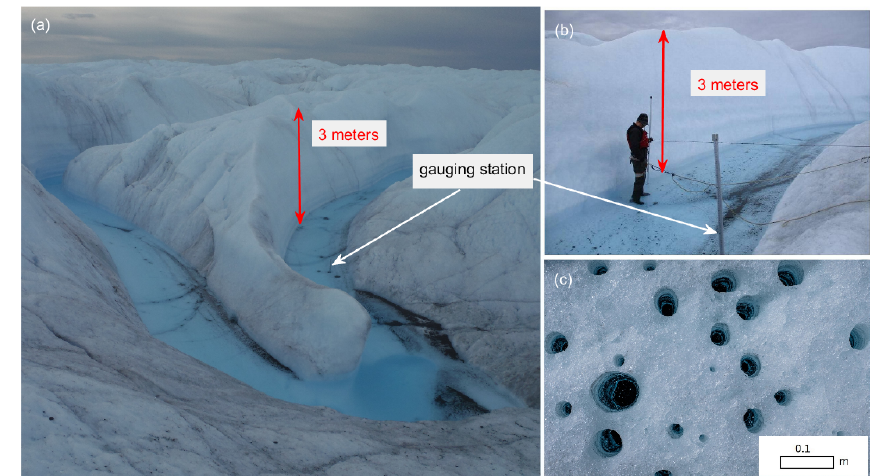
Figure 2. (a) Supraglacial stream main stem and gauging station location. (b) Close-up photo of the stream cross-section and the gauging station during discharge measurement. (c) Cryoconite holes on the bare-ice surface vary from 0.02–0.08m in diameter and 0.1–0.3m in depth (in this figure). These holes are partially water filled and contain cryoconite (biological matter, dust, and sediment) at the bottom.